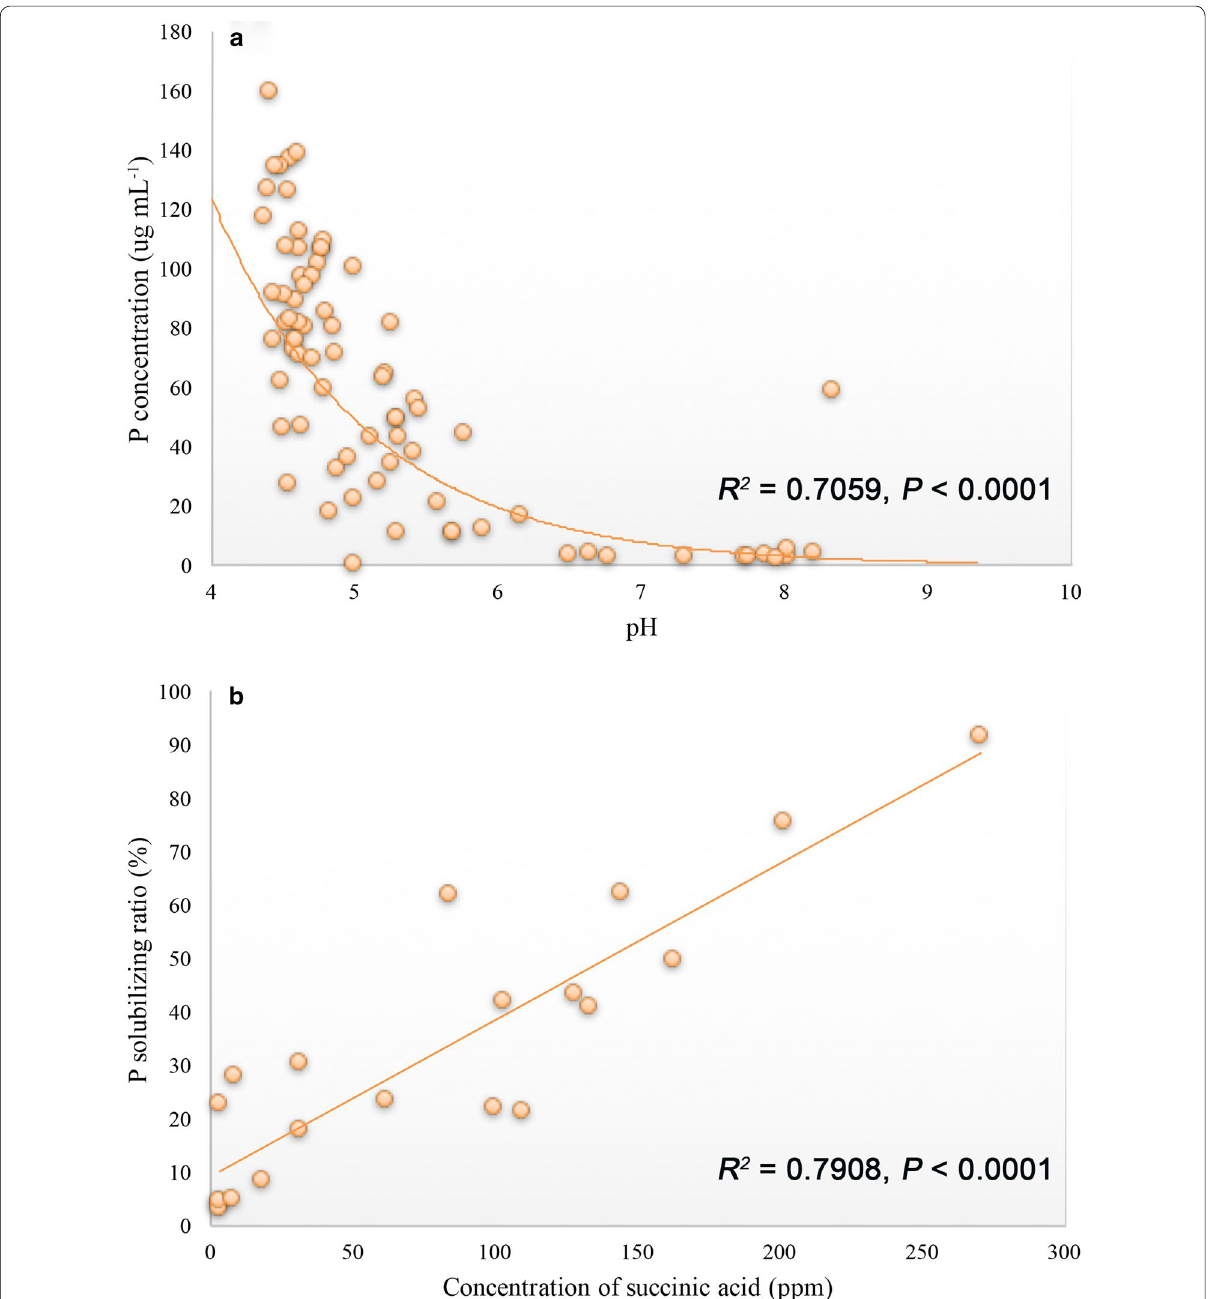
Fig. 5 Regression analysis of a the correlation between pH and P release for all iPSB strains (regression function: y relation between the concentration of succinic acid and the P‑solubilizing percentage for the four representative iPSB strains (regression function: y 0.2925x = +